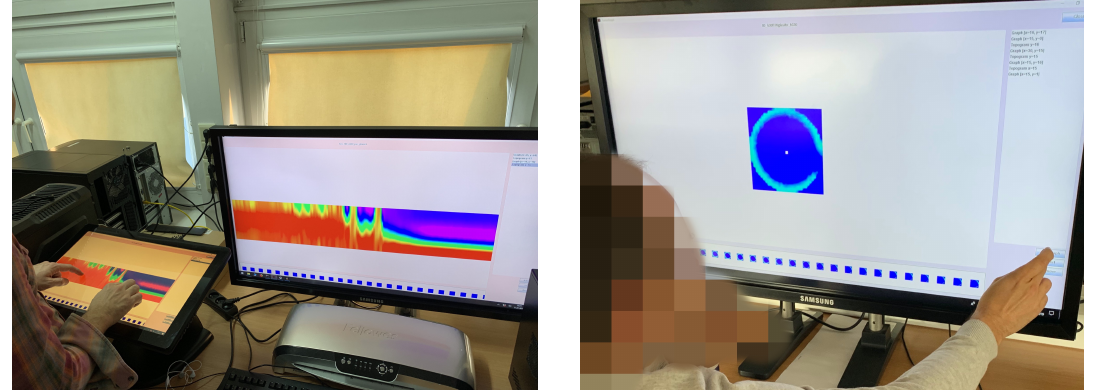
Figure 8. User working with the prototype system. ( Left ) two display setups (one horizontal multi-touch 20-inch surface plus one vertical classical 27-inch monitor). ( Right ) 40-inch vertical multi-touch